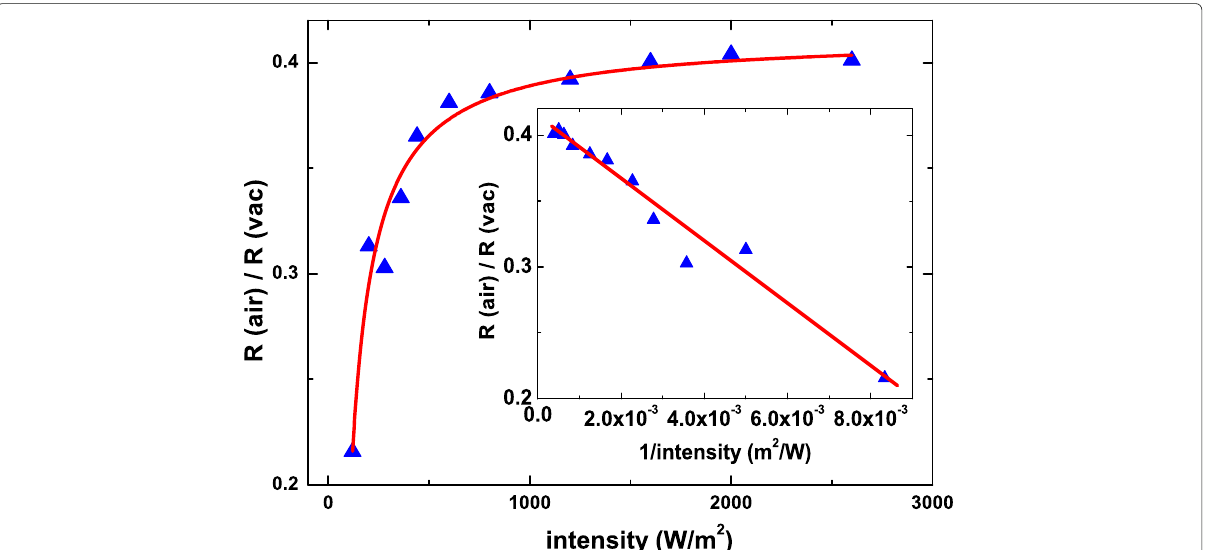
Fig. 6 The ratio of the responsivity in air to that in vacuum as a function of the light power intensity. The data points go well with the theoretical predication. The inset shows the ratio of the responsivity in air to that in vacuum is negatively proportional to the the inverse of the light power intensity